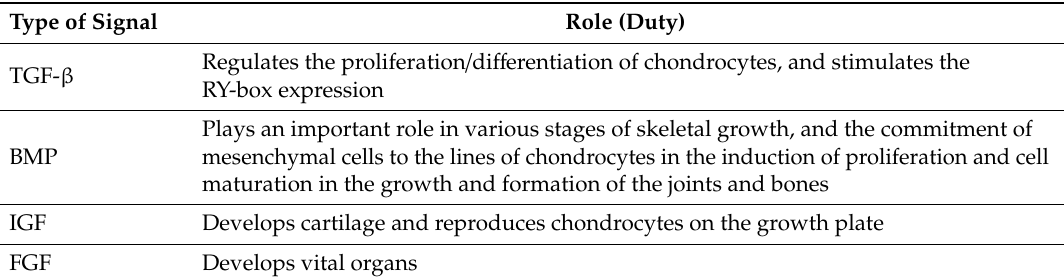
Table 1. The di ff erent types of signal plus their functionalities and crucial roles in the maintenance of cartilage homeostasis [43].